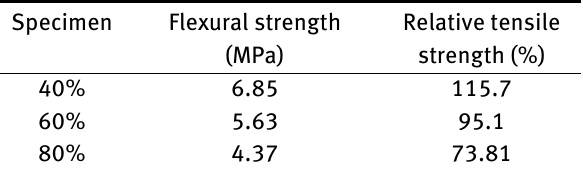
Table 26: Absorption of geopolymer mortar reinforced with 1%